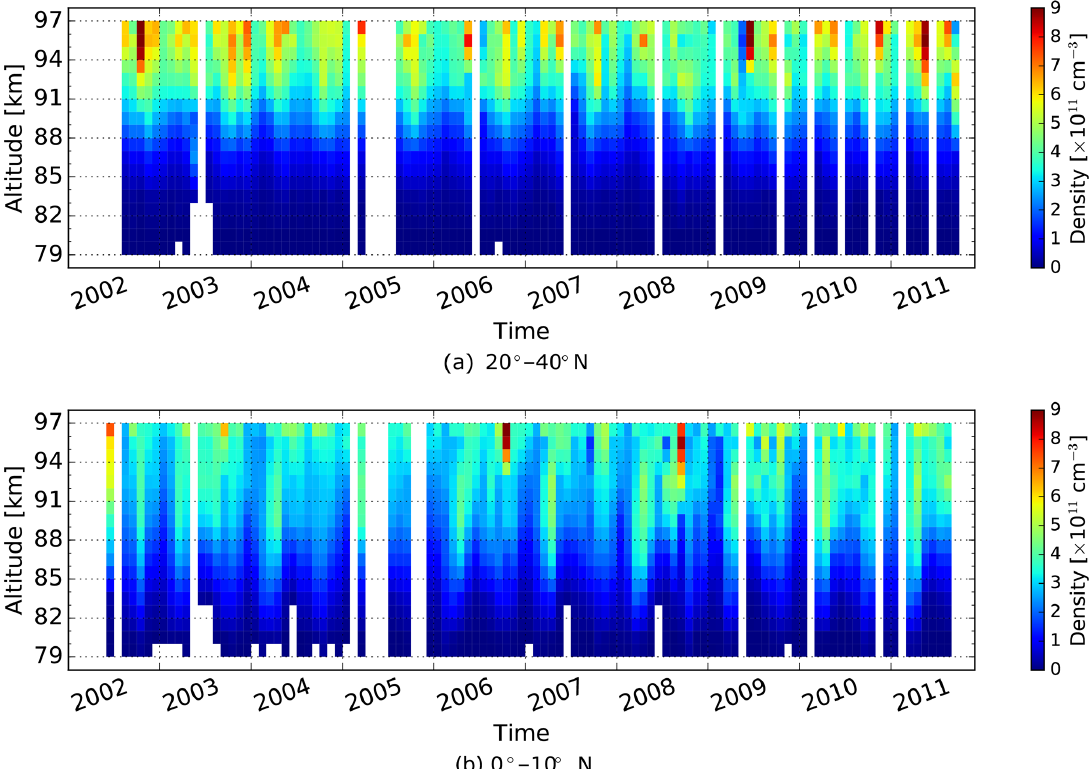
Figure 9. Temporal evolution of the vertical distribution of monthly zonal mean atomic oxygen densities for 20–40 ◦ N (a) and 0–10 ◦ N (b) . The data are linearly interpolated into a 1km altitude